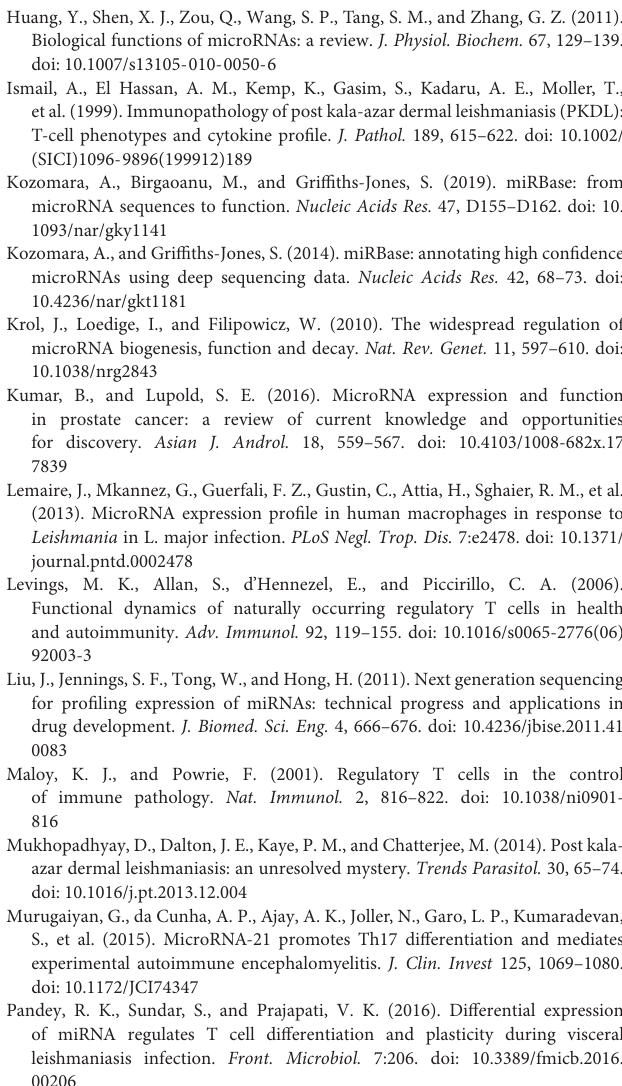
FIGURE S1 | Flow chart of work done. FIGURE S2 | Scatter plot of changes in regulations of known miRNAs in G PKDL versus G VL (A) and versus G THP (B) shows the scatter plot of upregulation of known miRNAs. FILE S1 | Fold change information of differentially expressed